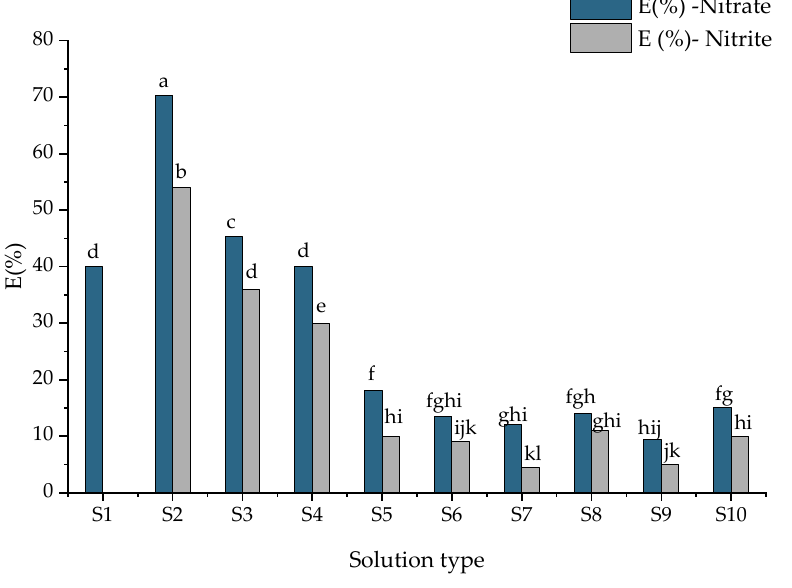
Figure 4. Nitrate and nitrite removal efficiency (E, %) depending on sample types. Data are the mean ± standard deviation ( n = 3). Means with different letters (a–k) above the bars indicate significant differences based on Tukey’s test ( p < 0.05).